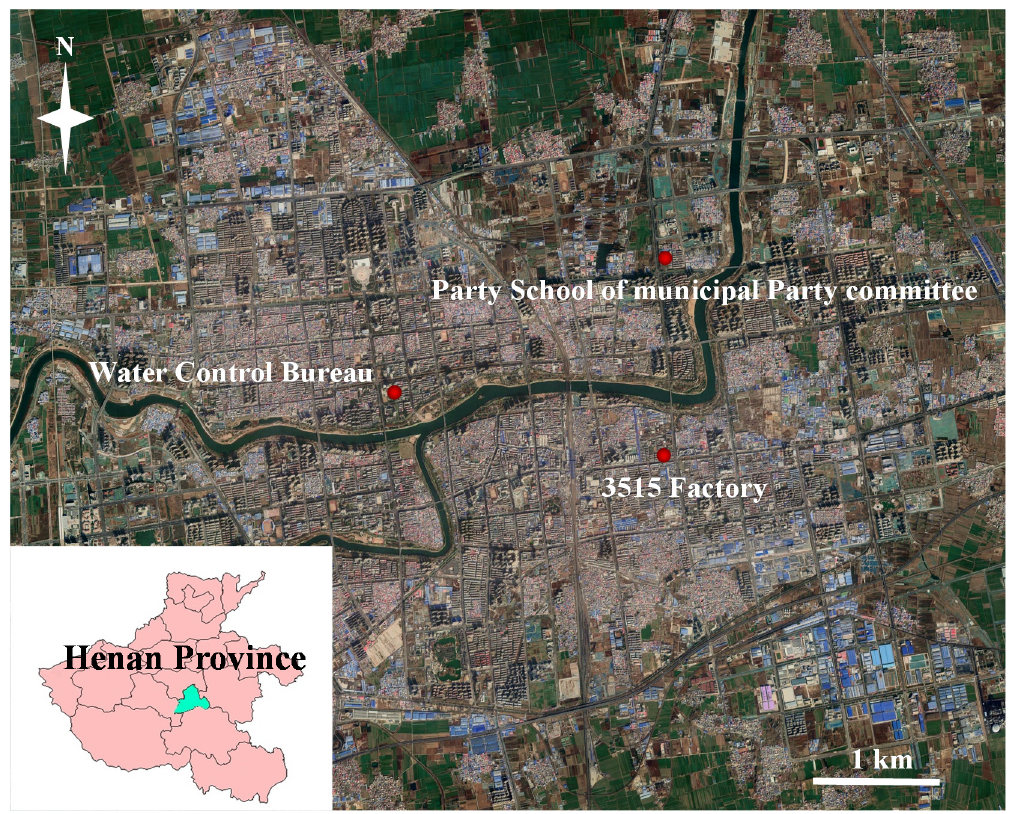
Figure 1. Distribution of the three sampling sites in Luohe City.